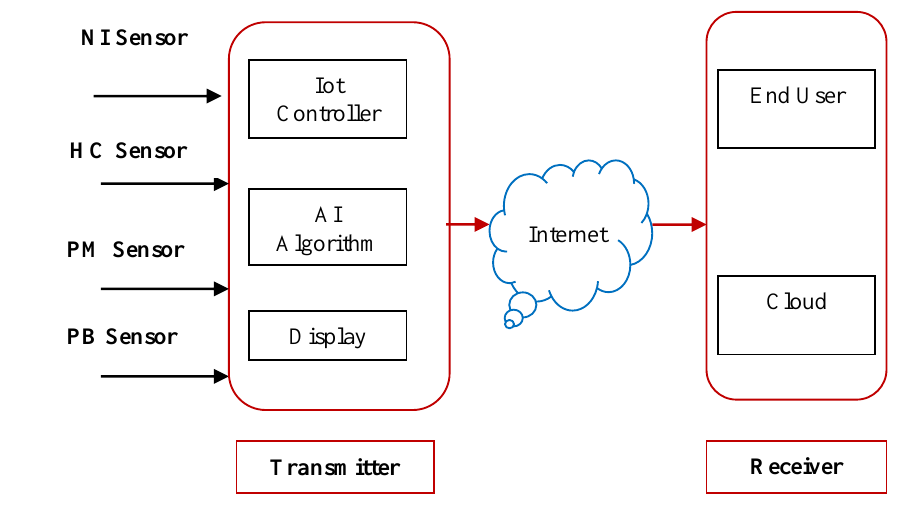
Fig 1 . IoT Based System for Monitoring Hazardous Exhaust compound in air IoT is nothing but the interconnected devices network, which are supported with